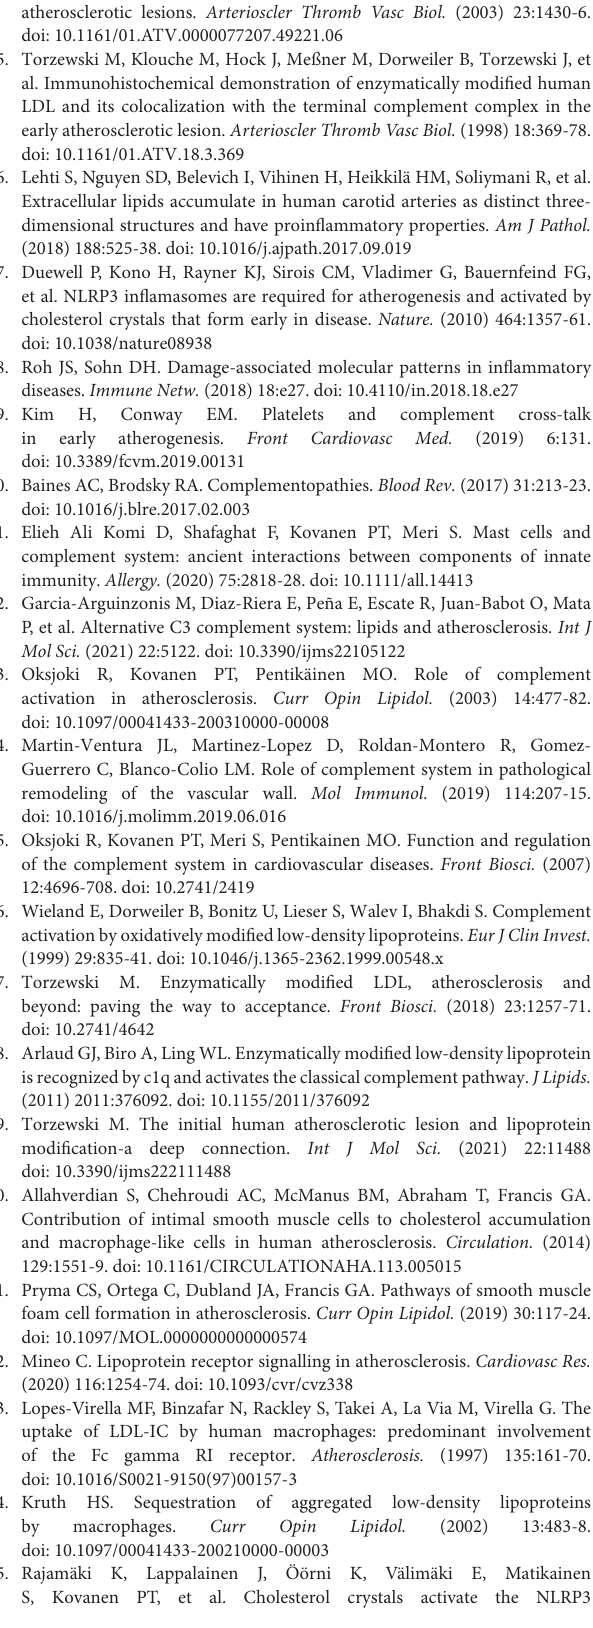
Tabas I. Rabbit aorta and human atherosclerotic lesions hydrolyze the sphingomyelin of retained low-density lipoprotein. Proposed role for arterial-wall sphingomyelinase in subendothelial retention and aggregation of atherogenic lipoproteins. J Clin Invest. (1996) 98:1455-64. doi: 10.1172/JCI118934 50. Oorni K. Sphingomyelinase induces aggregation and fusion of small very low-density lipoprotein and intermediate-density lipoprotein particles and increases their retention to human